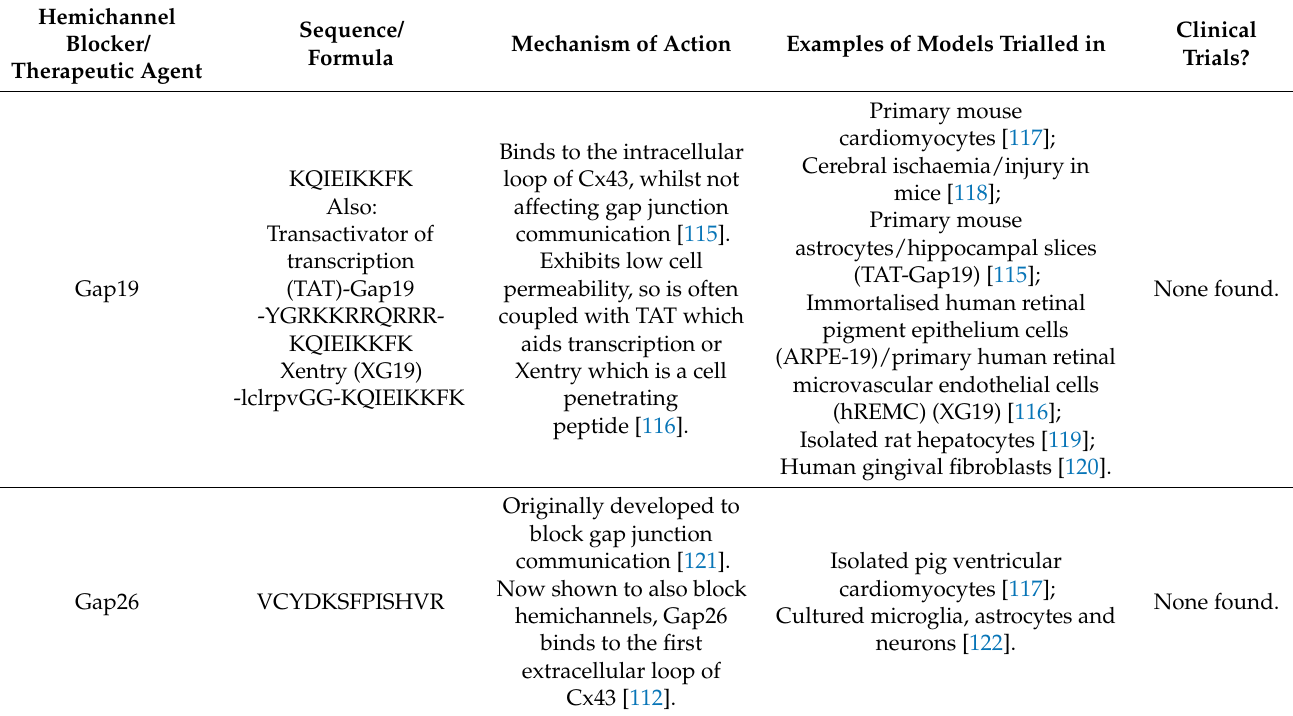
Table 1. Cx43 hemichannel blockers, mechanism of action and models in which they have been trialled to